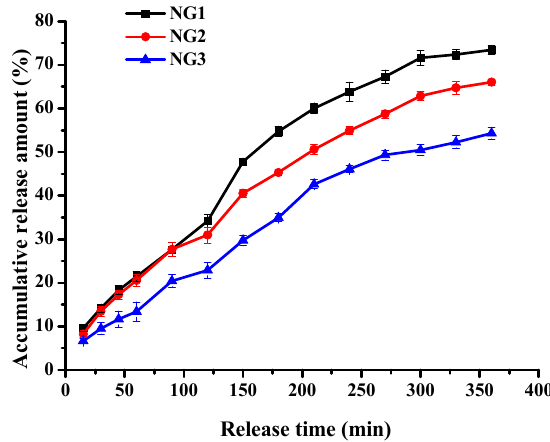
Figure 10. Release of riboflavin in simulated gastric and intestinal fluid from NG1, NG2 and NG3. The data with different lowercase letters in the same test are significantly ( p < 0.05) different.